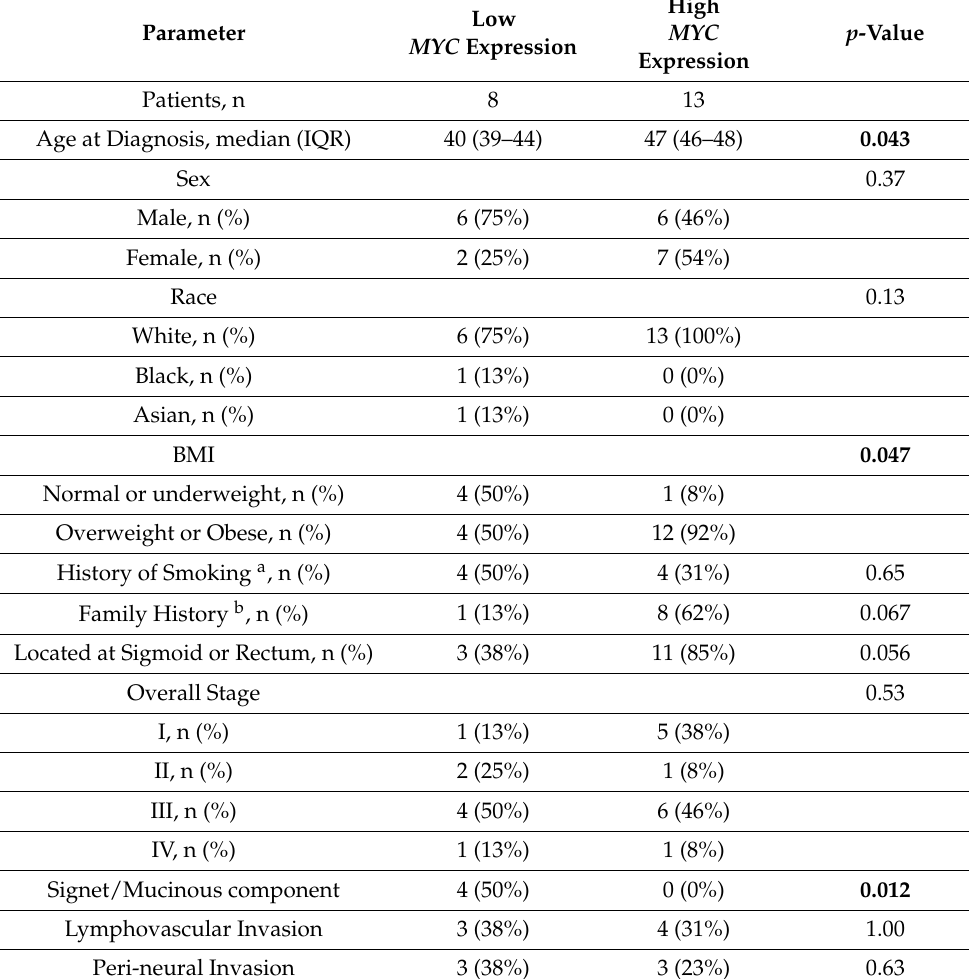
Table 2. Patient demographics for low and high differential MYC